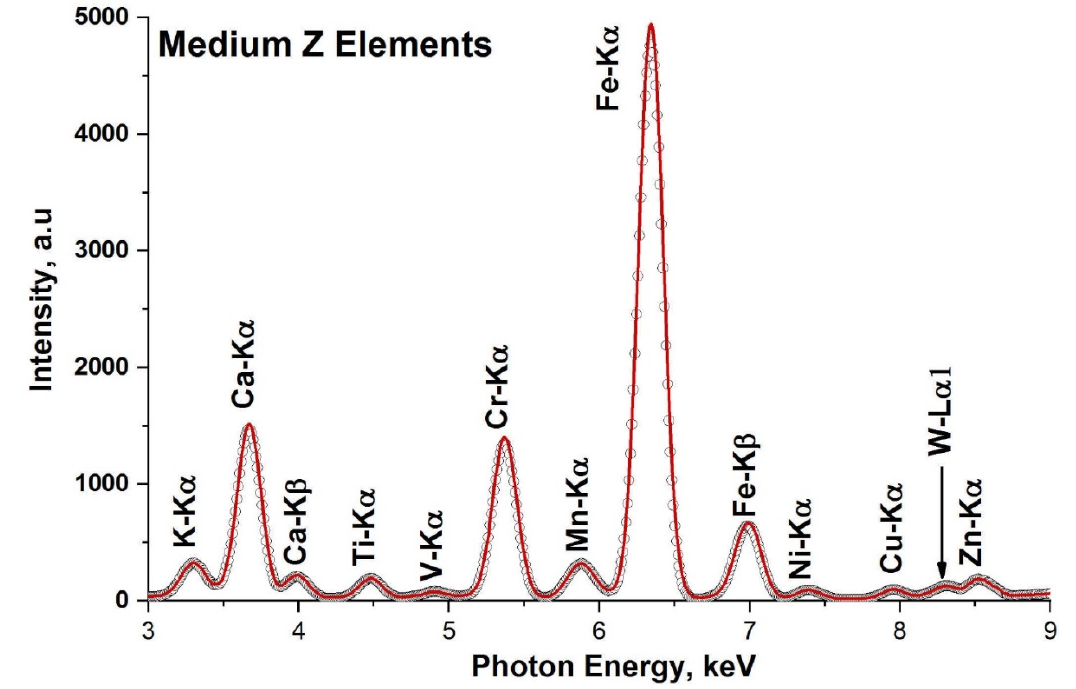
Figure 6. The EDXRF spectrum of the medium Z elements using Ge secondary target for selected PM 2.5 sample from historical Jeddah district, Saudi Arabia.